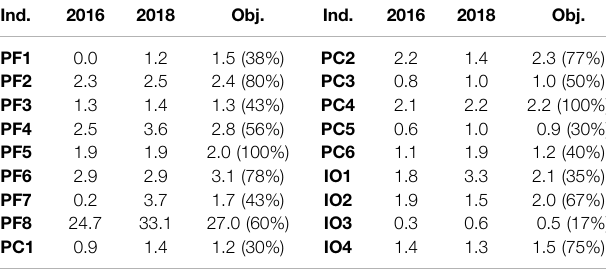
TABLE 7 | Comparison between 2016 and 2018 of C 10 . Ind.